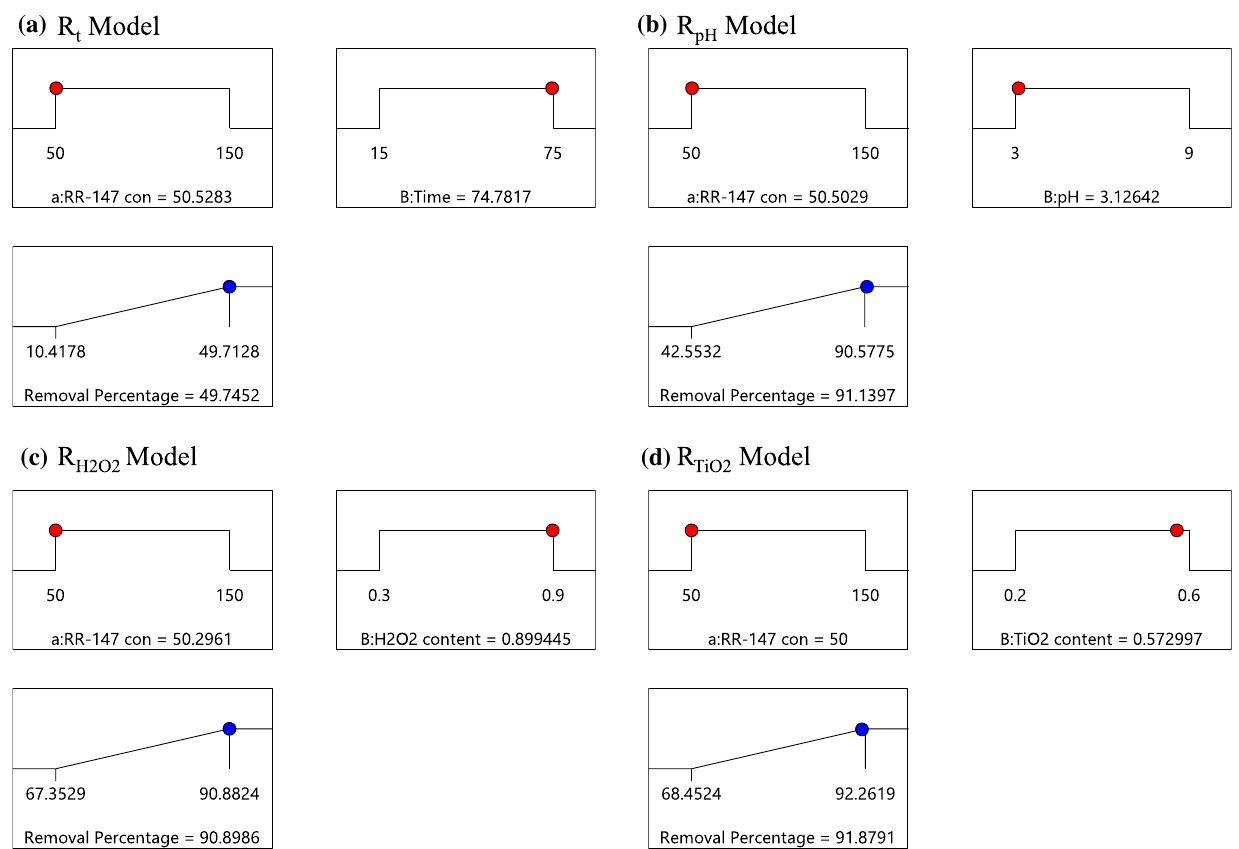
R R H 2 O 2 and d TiO t ; b R pH ; c